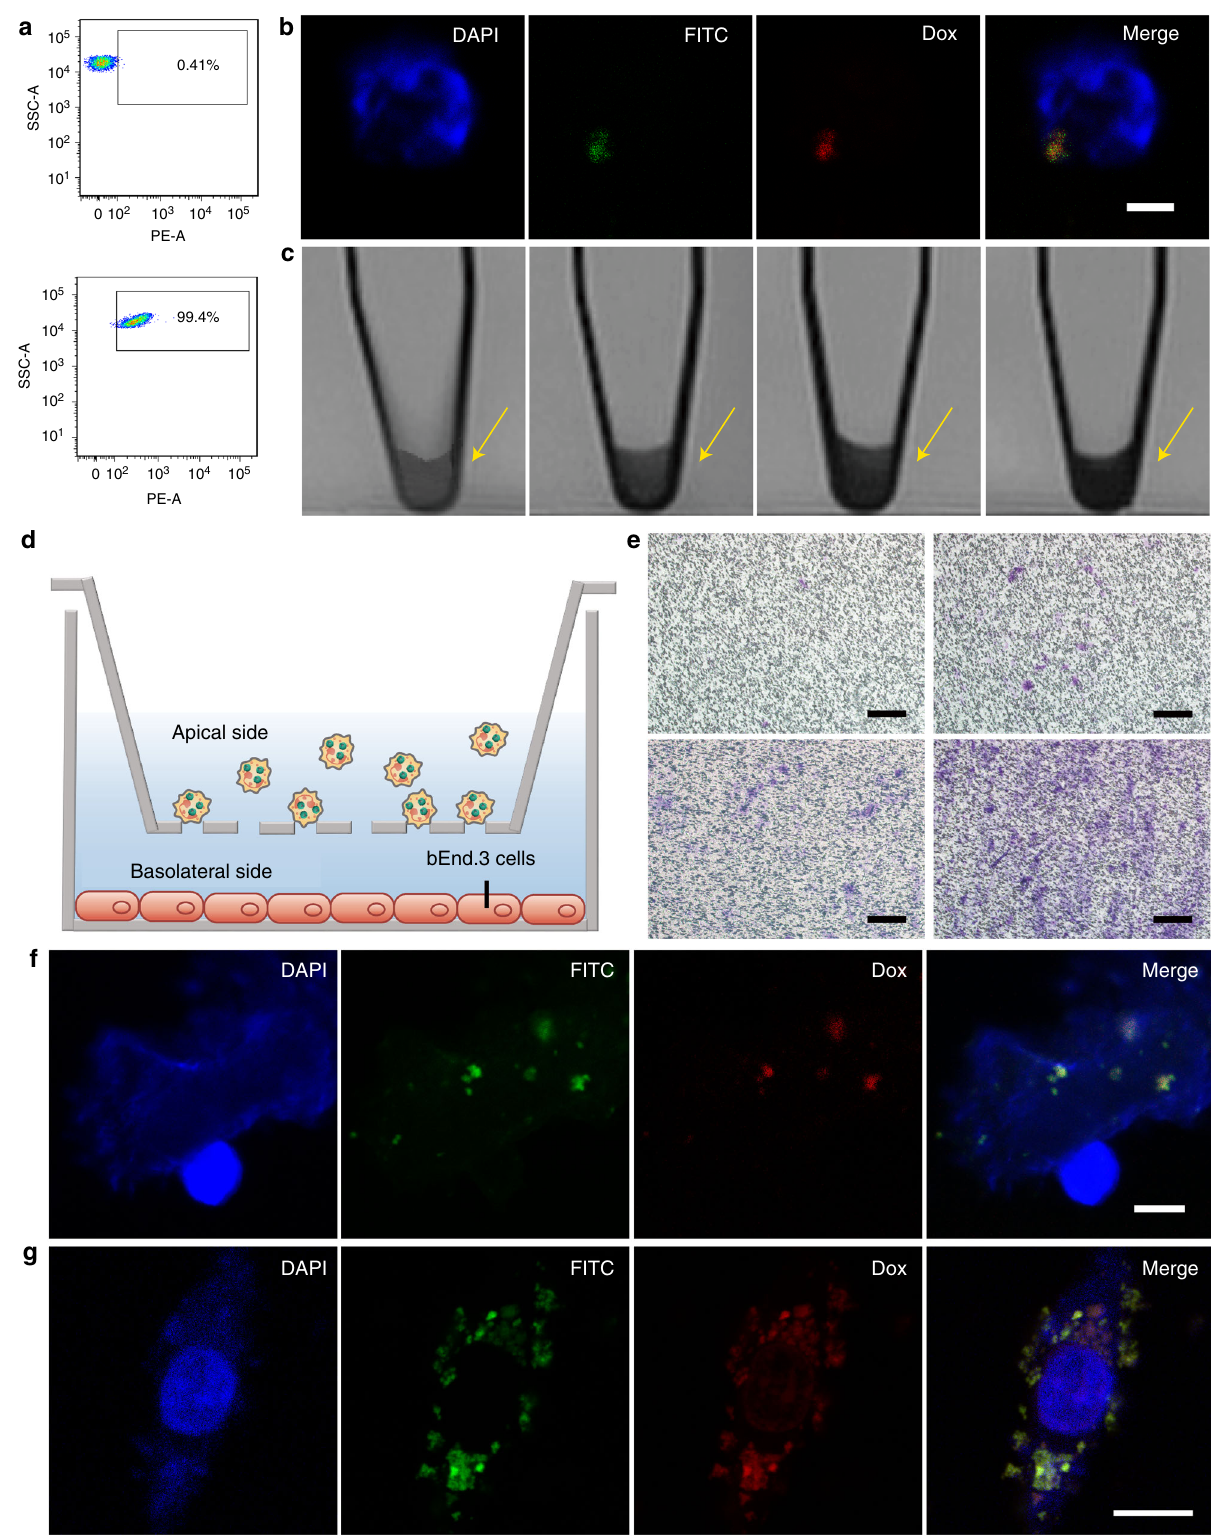
neutrophils bearing D-MMSNs migrate through the transwell membrane pore when the subnatant well is fi lled with fresh serum-free media. By contrast, the number of neutrophils moving across the transwell membrane increases over time when the bEnd.3 endothelial cell monolayers were treated with